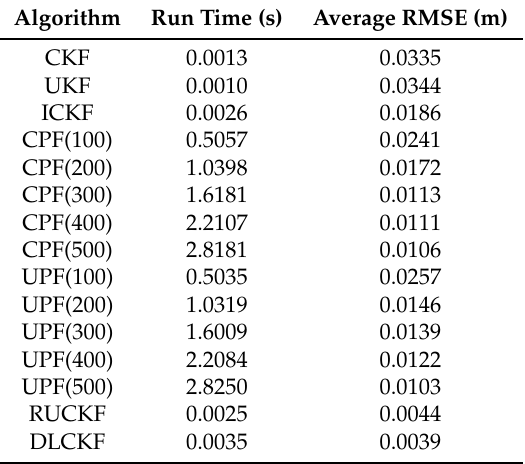
Table 1. The run time and the average RMSE of each algorithm.